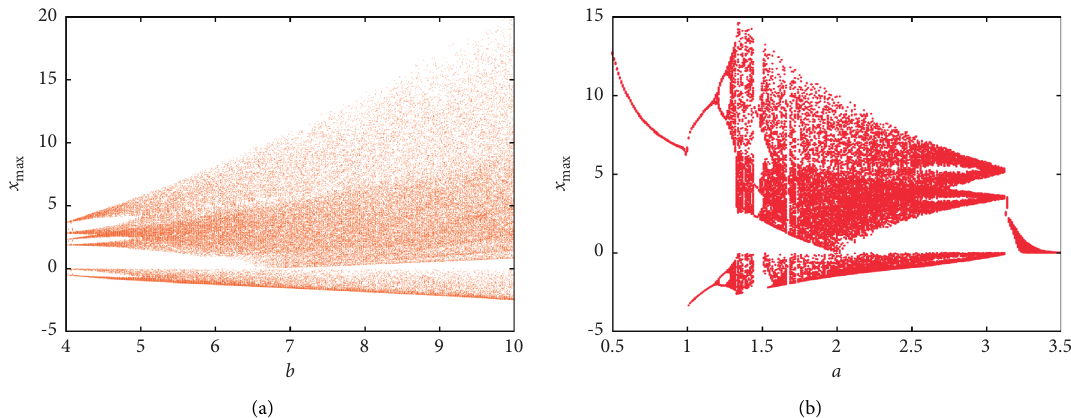
Figure 12: Bifurcation diagrams of the Rucklidge system showing local maxima of the x variable in one complete orbit, x different parameters.